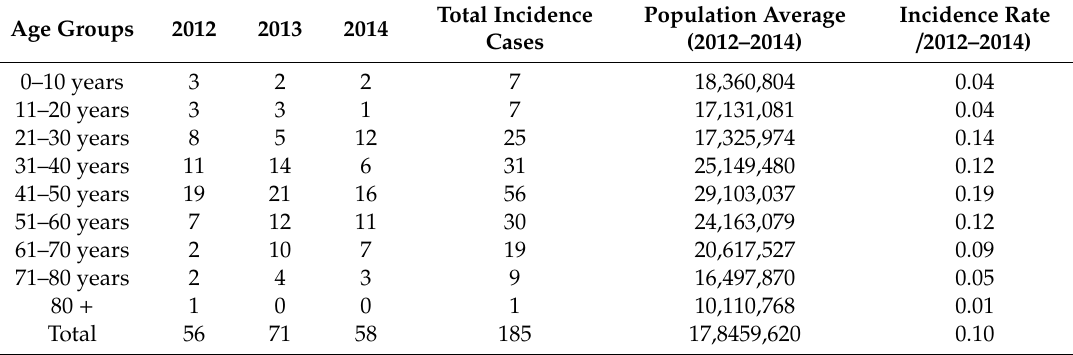
Table 3. Incidence rate with primary sclerosing cholangitis and age specific incidence rate per 100,000 individuals from 2012 to